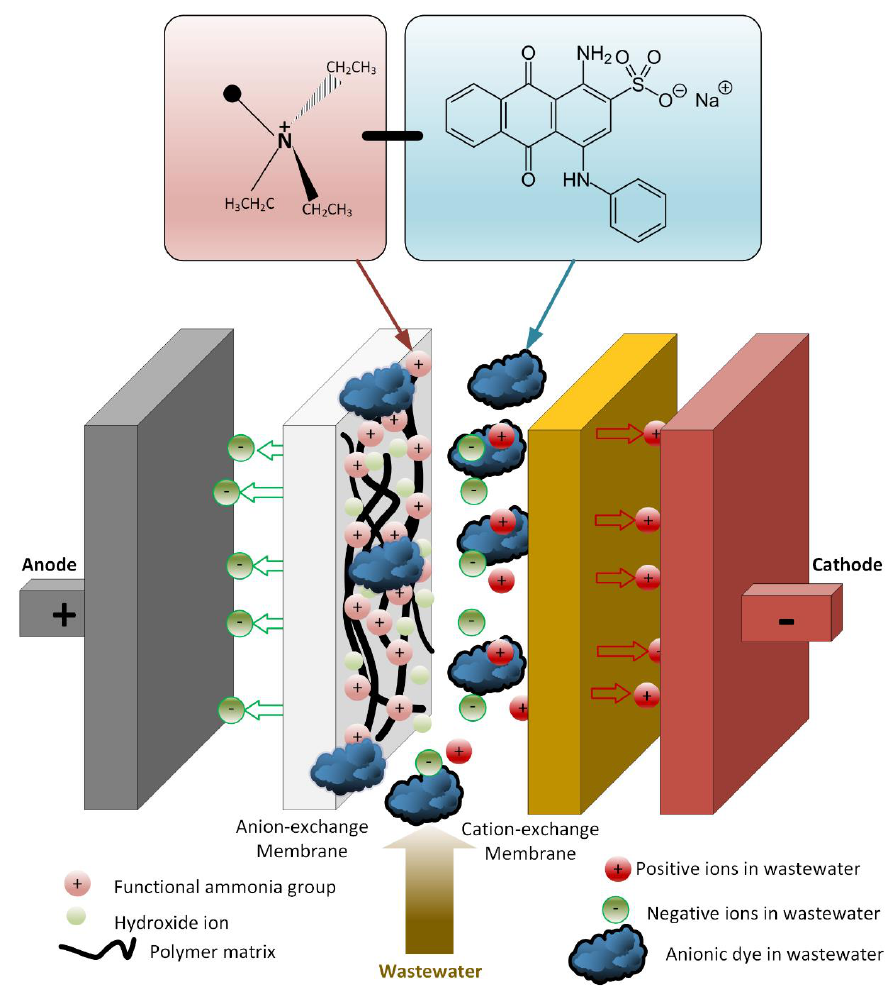
Figure 9. Schematic representation of membrane clogging due to the negatively charged dyestuffs.